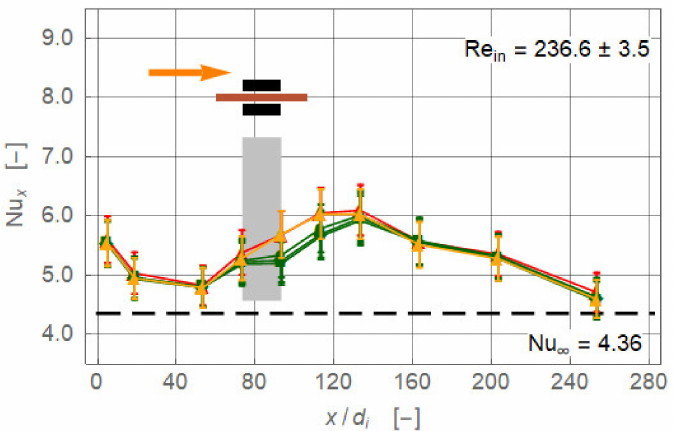
Figure 5. Local Nusselt number along non-dimensional axial coordinate for the magnet configura- tions single magnet below and above and two attracting magnets ( r cl = 55 mm). Symbols indicate experimental data. Data points connected only to improve visibility. The colours stand for ferro- nanofluid without single magnet (red), with single magnet below (orange), and with magnet(s) (green: (cid:4) above, (cid:7) above and below attracting, and • above and below repulsing). All other symbols and marks are as in Figure